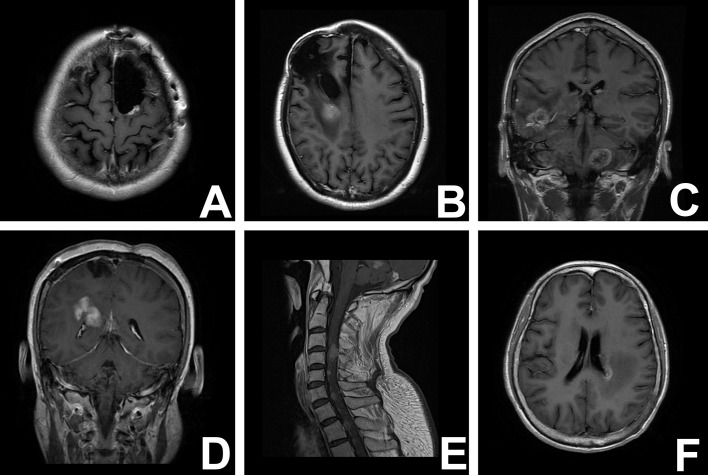
T1-weighred magnetic resonance images illustrate the different recurrent patterns of glioma. (A) local recurrence; (B) marginal recurrence; (C) multirecurrence; (D) distant recurrence; (E) subarachniod recurrence; (F) paraventricular recurrence.